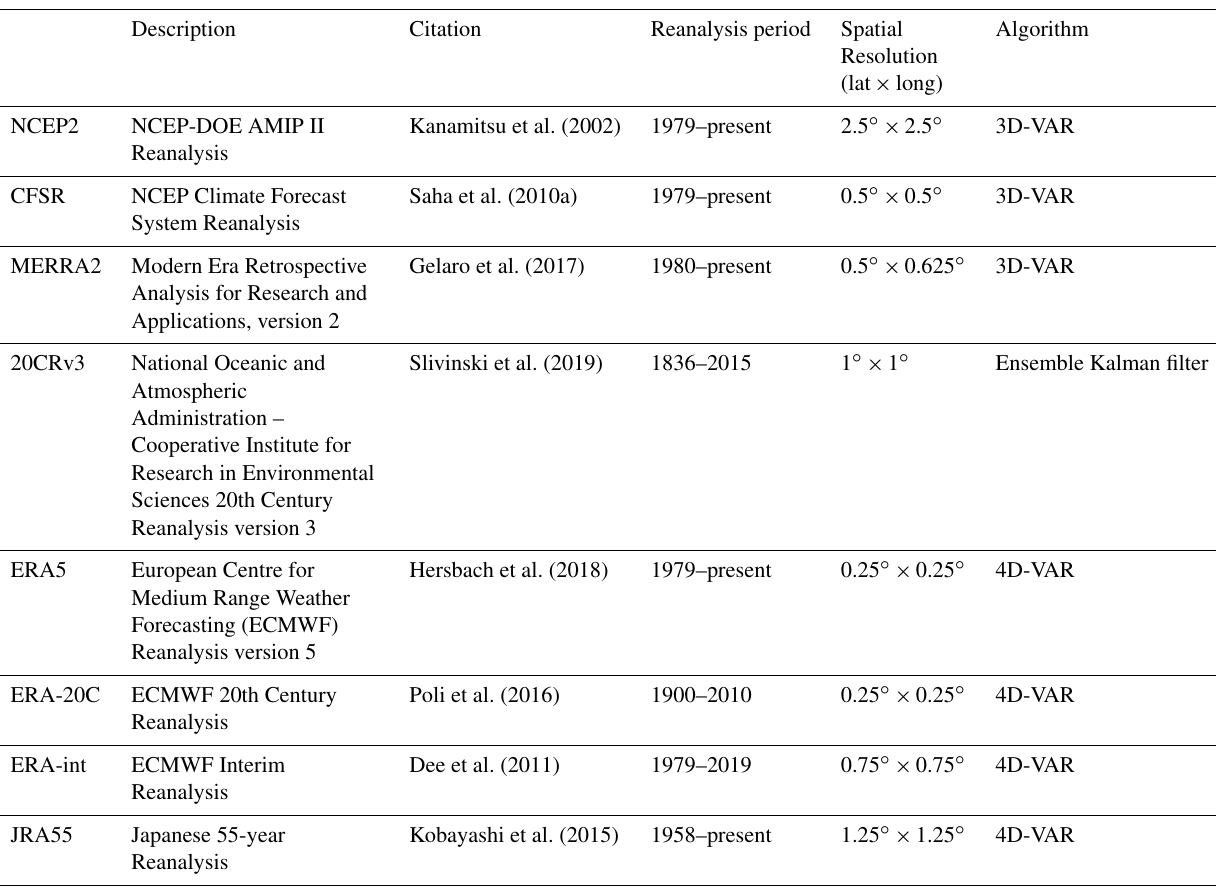
Table 1. Summary of reanalysis products used in this